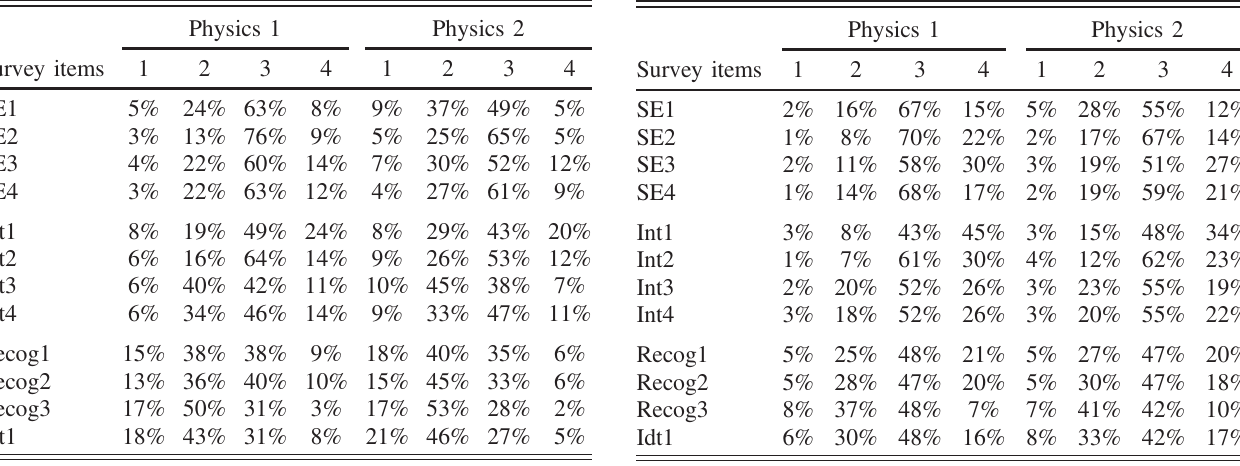
TABLE XI. Percentages of female students who selected each choice from a 4-point Likert scale for each survey item in physics 1 and physics 2. The self-efficacy and interest (Int) items have the response scale: 1 ¼ NO ! , 2 ¼ no, 3 ¼ yes, and 4 ¼ YES ! , while the perceived recognition and identity (Idt1) items have the response scale: 1 ¼ strongly disagree, 2 ¼ disagree, 3 ¼ agree, and 4 ¼ strongly agree.